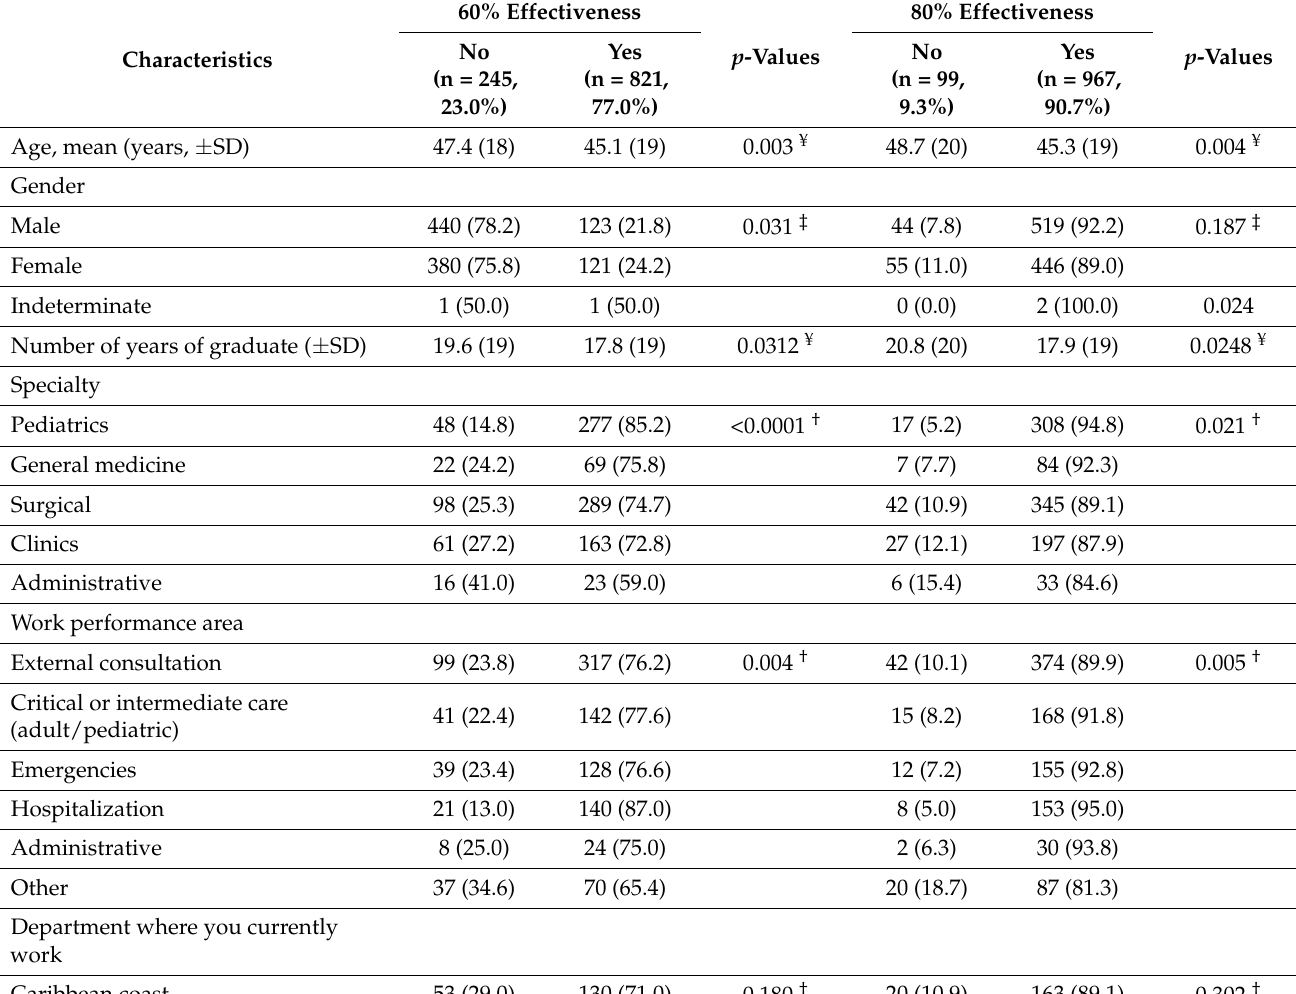
Table 1. Characteristics of the population according to the acceptance of free vaccination with an effectiveness of 60% and